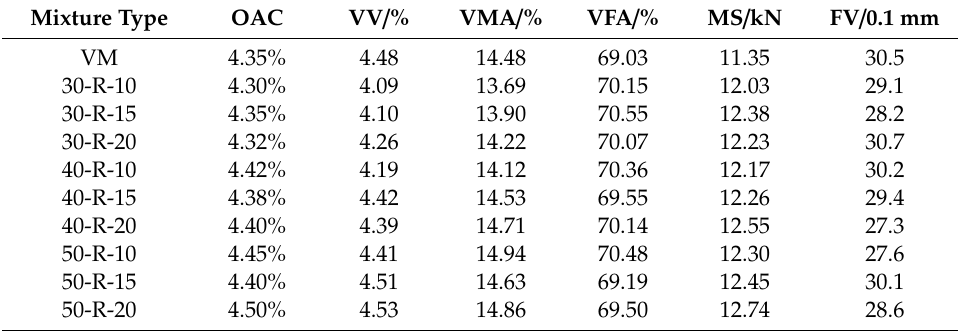
Table 9. The volumetric and mechanical properties of recycled mixtures with di ff erent reclaimed asphalt pavement (RAP) and fine reclaimed asphalt pavement (FRAP)